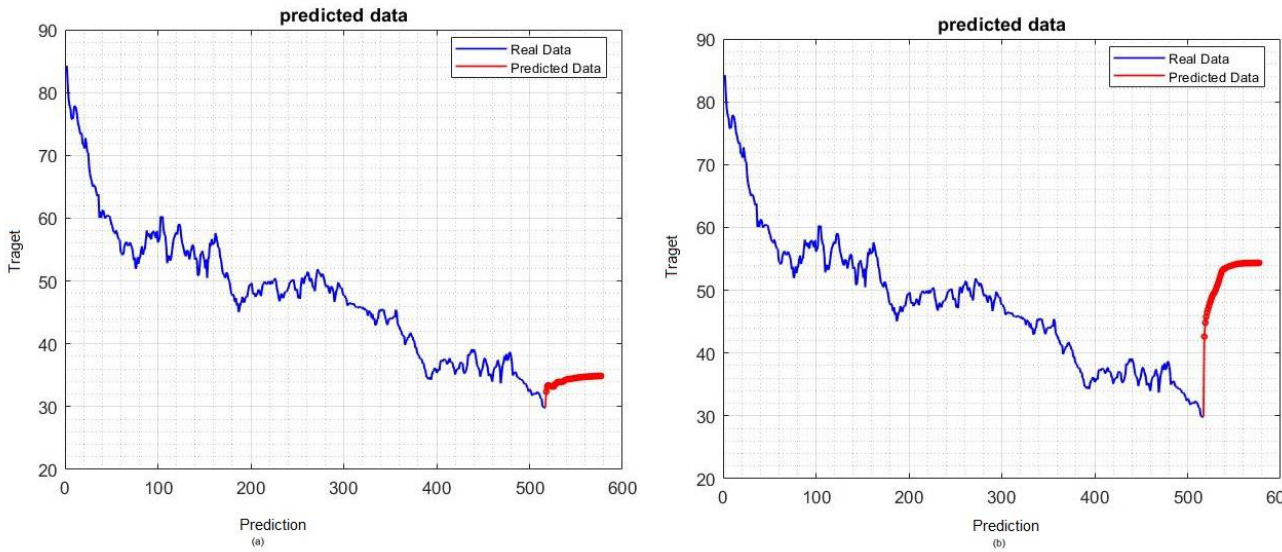
Figure 15. Forecasting the future values of Apple using ( a ) CNN-LSTM and ( b ) LSTM.